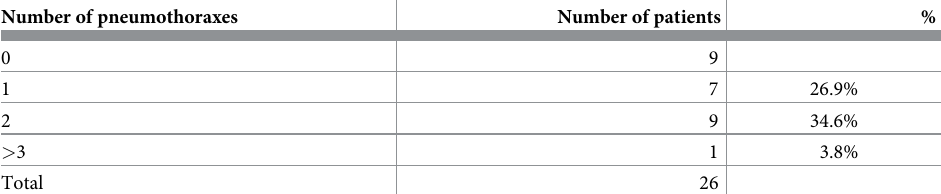
Table 4. Number of pneumothoraxes among BHD